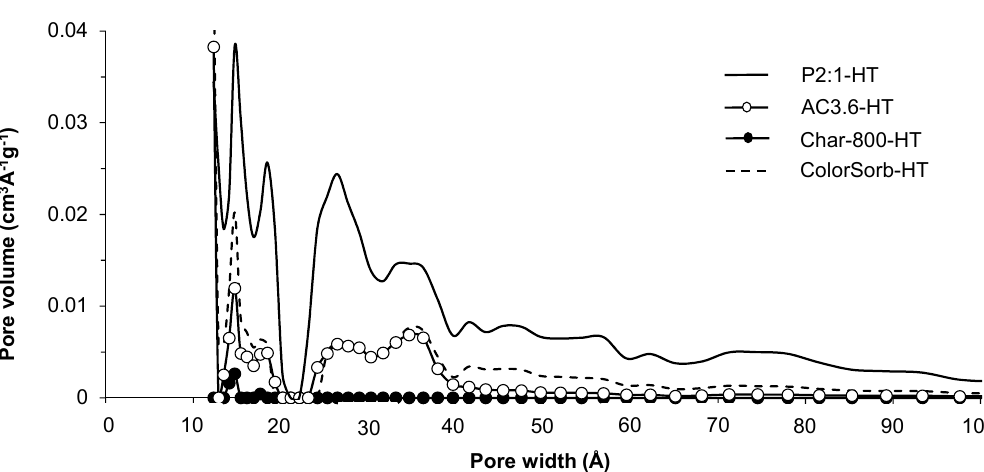
Figure 1. Pore size distributions of selected activated carbon determined with non-local density functional theory.